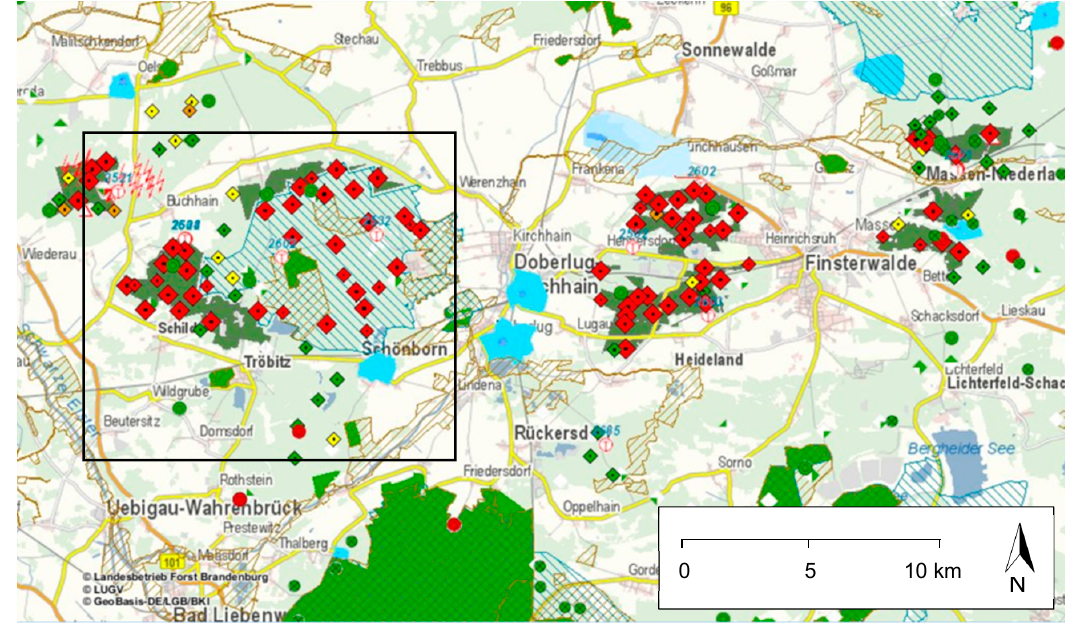
Figure 3. GIS documentation of monitoring data for Diprion pini in summer 2016 as threshold numbers (TN) deduced from found egg numbers. Red diamonds indicate a prognosis of total needle loss for the respective stands, green diamonds represent inconspicuous TN. The square in the left part of the map delimits the area shown in Figure 4.